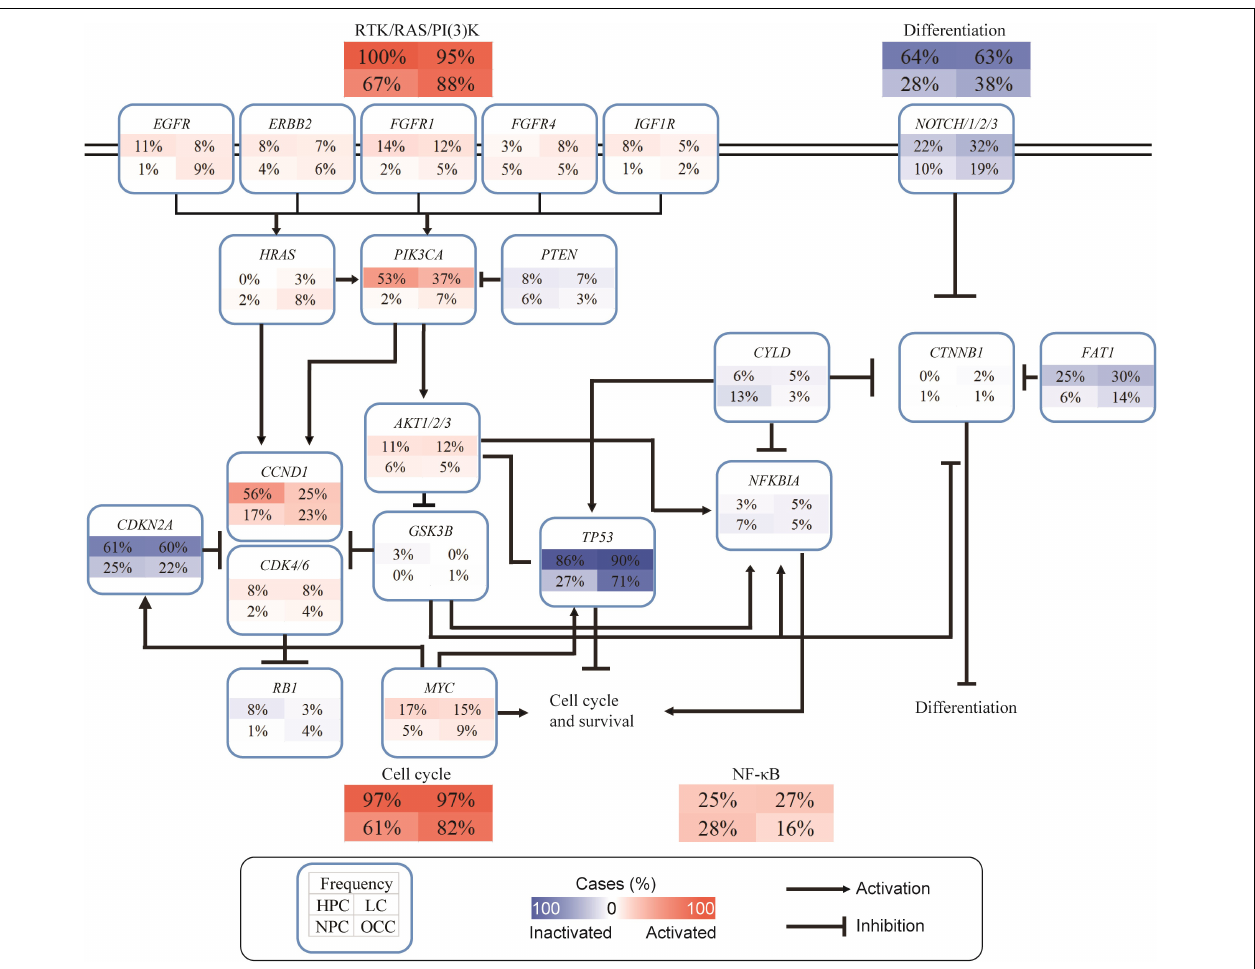
FIGURE 4 | Deregulated cancer-related pathways in Chinese HNSCCs. Pathway alterations include SNVs, INDELs, and CNVs. Each number in box indicates percentage (%) of altered samples of given gene or pathway. Frequency of different anatomic sites is shown separately within subpanels. Activated and inactivated pathways or genes are based on predicted effects of alterations and/or pathway